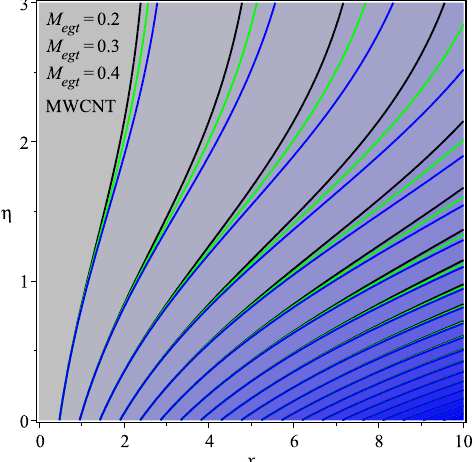
Figure 22. Repercussion of M egt with φ = 0.1, ω = π /3, Ω = 1, κ = 2.5 on stream lines.